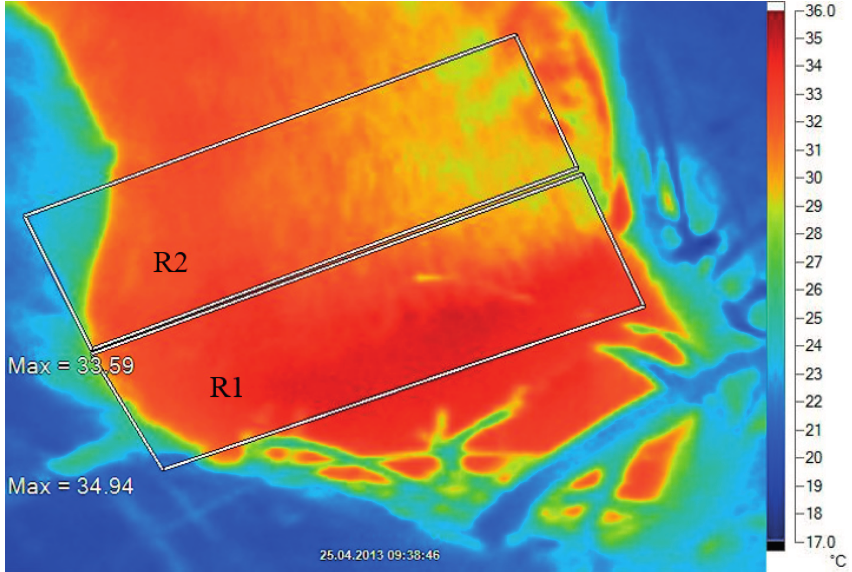
Figure 1. Infrared thermography image of the right rear foot (lateral aspect) as described by Alsaaod et al. [26,28]. R1 is the area of interest for measurement of the maximal temperature of the coronary band, defined as the hottest pixel measured by thermography in the junction between the skin and the horn of the claw; R2 is the area of interest for measurement of the maximal temperature of the skin, defined as the hottest pixel measured by thermography in the skin area, neighbouring R1